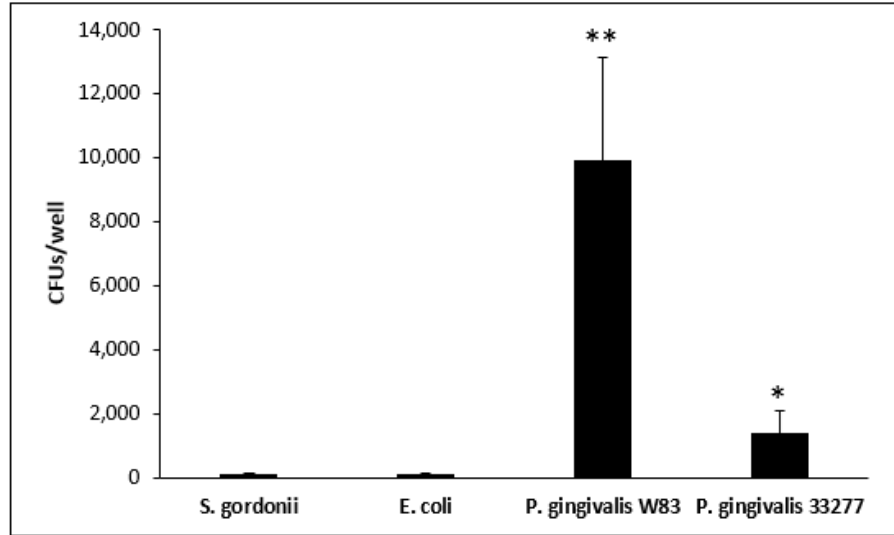
Figure 6. Escape from infected THP-1 M1 cells and re-entry into uninfected THP-1 M1 cells